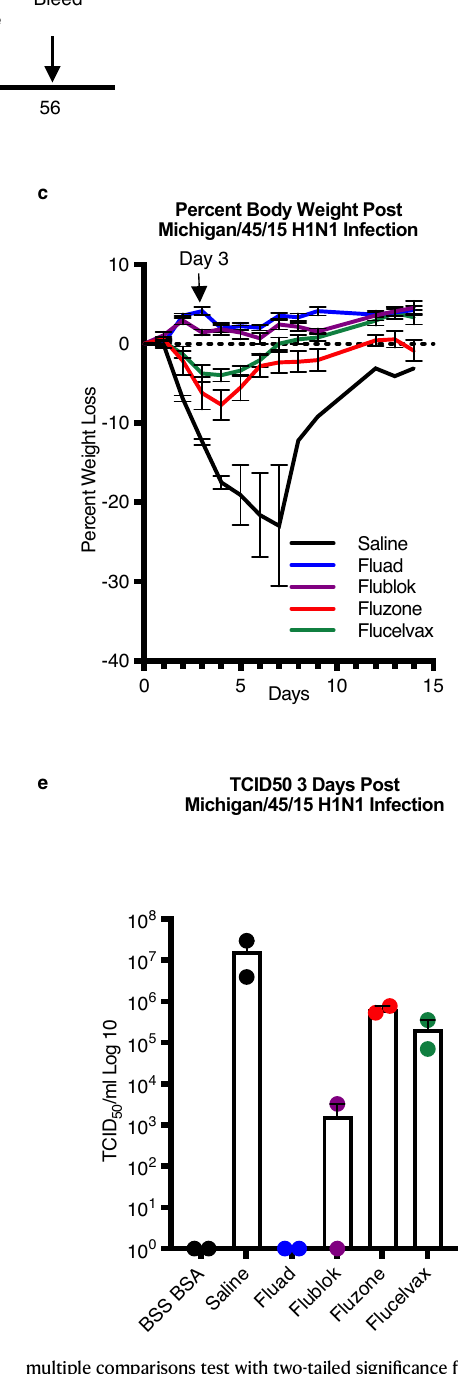
Fig. 6 | Protection ef fi cacy and weight lost differences after H1N1 challenge. a Mice were immunized with commercial in fl uenza vaccines (day 0 and 21) and challenge with A/Michigan/45/2015 H1N1 in fl uenza virus at 10x the lethal dose for control mice (day 42). b Survival curves for mice ( N =5) immunized with saline control (black), Fluad (blue), Flublok (purple), Fluzone HD (red) and Flucelvax (green). c Weight-losscurvesforchallengedmice( N =5)thatwereimmunizedwith saline (black), Fluad (blue), Flublok (purple), Fluzone HD (red) and Flucelvax (green). The black arrow indicates weight-loss on day three post H1N1 challenge. d Statisticalanalysisofweight-lossdifferences( N =15mice)betweenimmunization groups for day 3 post H1N1 challenge (F (4, 70)=49.44, p <0.0001). Tukey ’ s